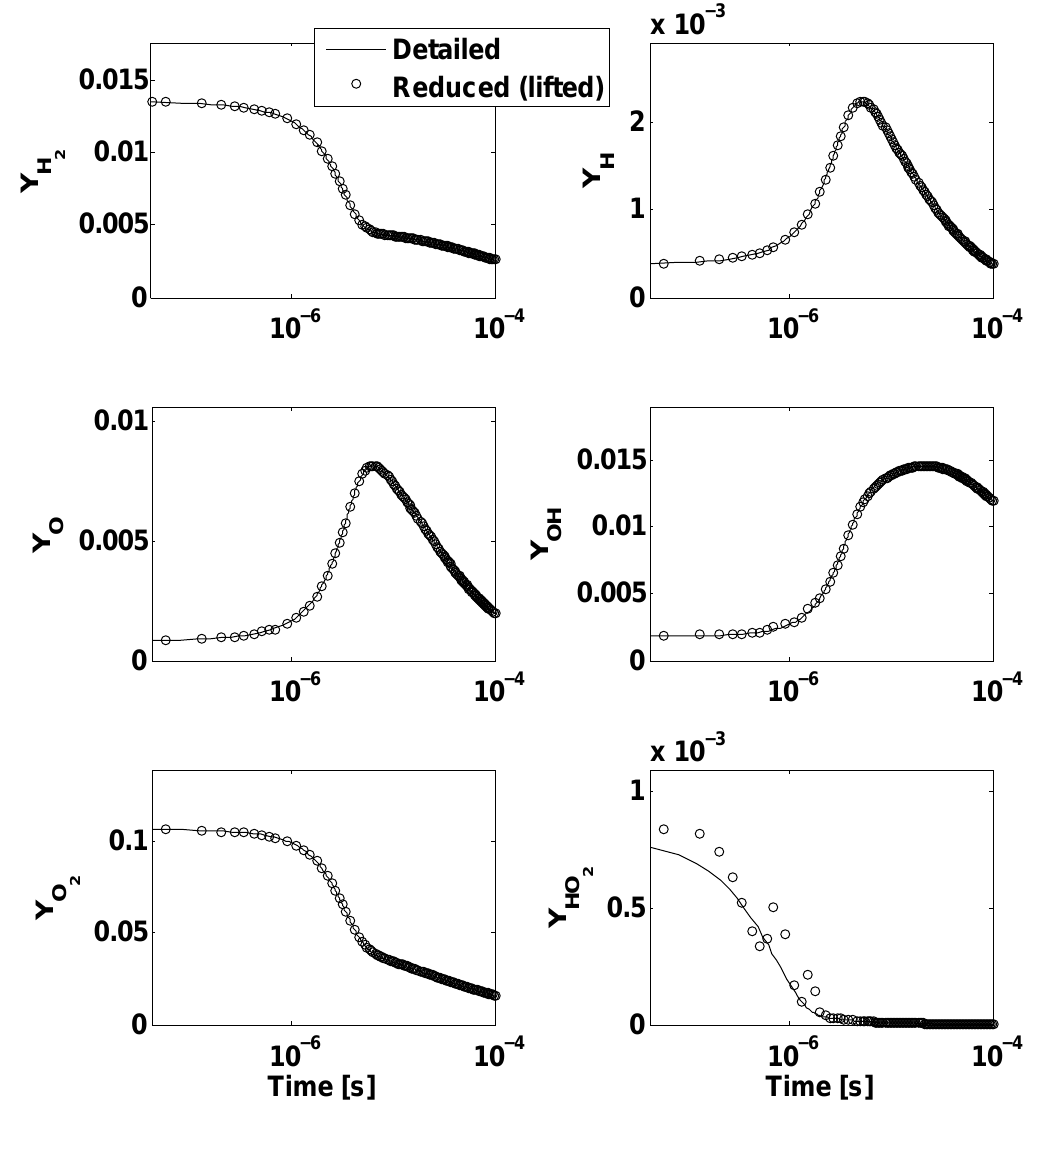
Figure 14. The initial condition in the Diffusion Maps’ space [0 , 0] is first lifted into (cid:60) 9 and then relaxed towards the equilibrium point by the detailed kinetics Equation (8) using the readily available Matlab solver, ode45 (continuous line). Symbols report the corresponding time series as obtained by lifting the reduced solution at the top of Figure 13 ( i.e. , Method 2). Detailed Reduced